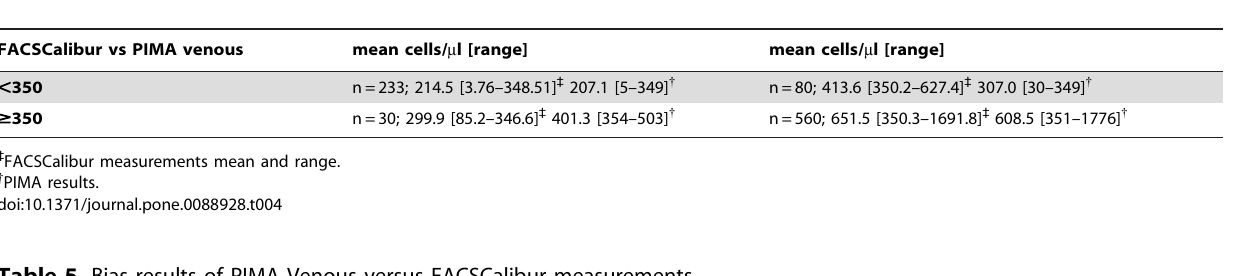
Table 5. Bias results of PIMA Venous versus FACSCalibur